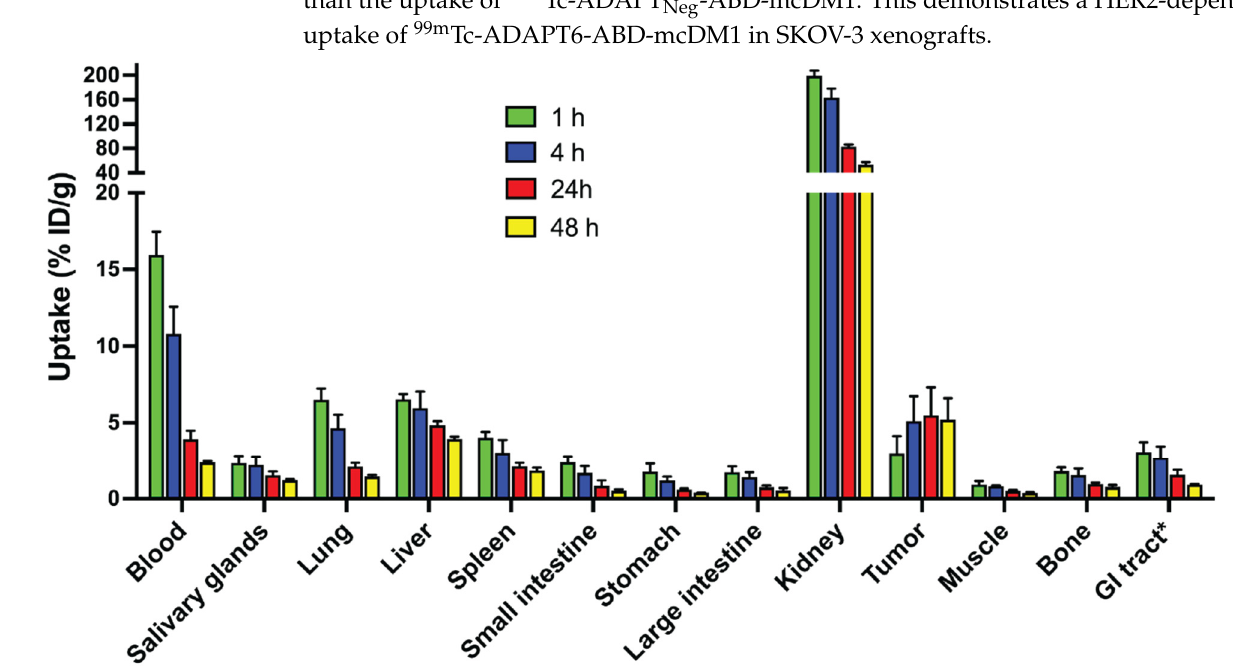
Figure 6. Biodistribution of 99m Tc-ADAPT6-ABD-mcDM1 in BALB/c nu/nu mice bearing HER2 expressing SKOV-3 xenografts at 1, 4, 24, and 48 h after injection. The radioactivity was calculated as percent of injected dose per gram tissue (% ID/g) and presented as the mean value from four mice ± 1 SD. * Data for gastrointestinal (GI) tract with content is presented as % ID per whole sample.